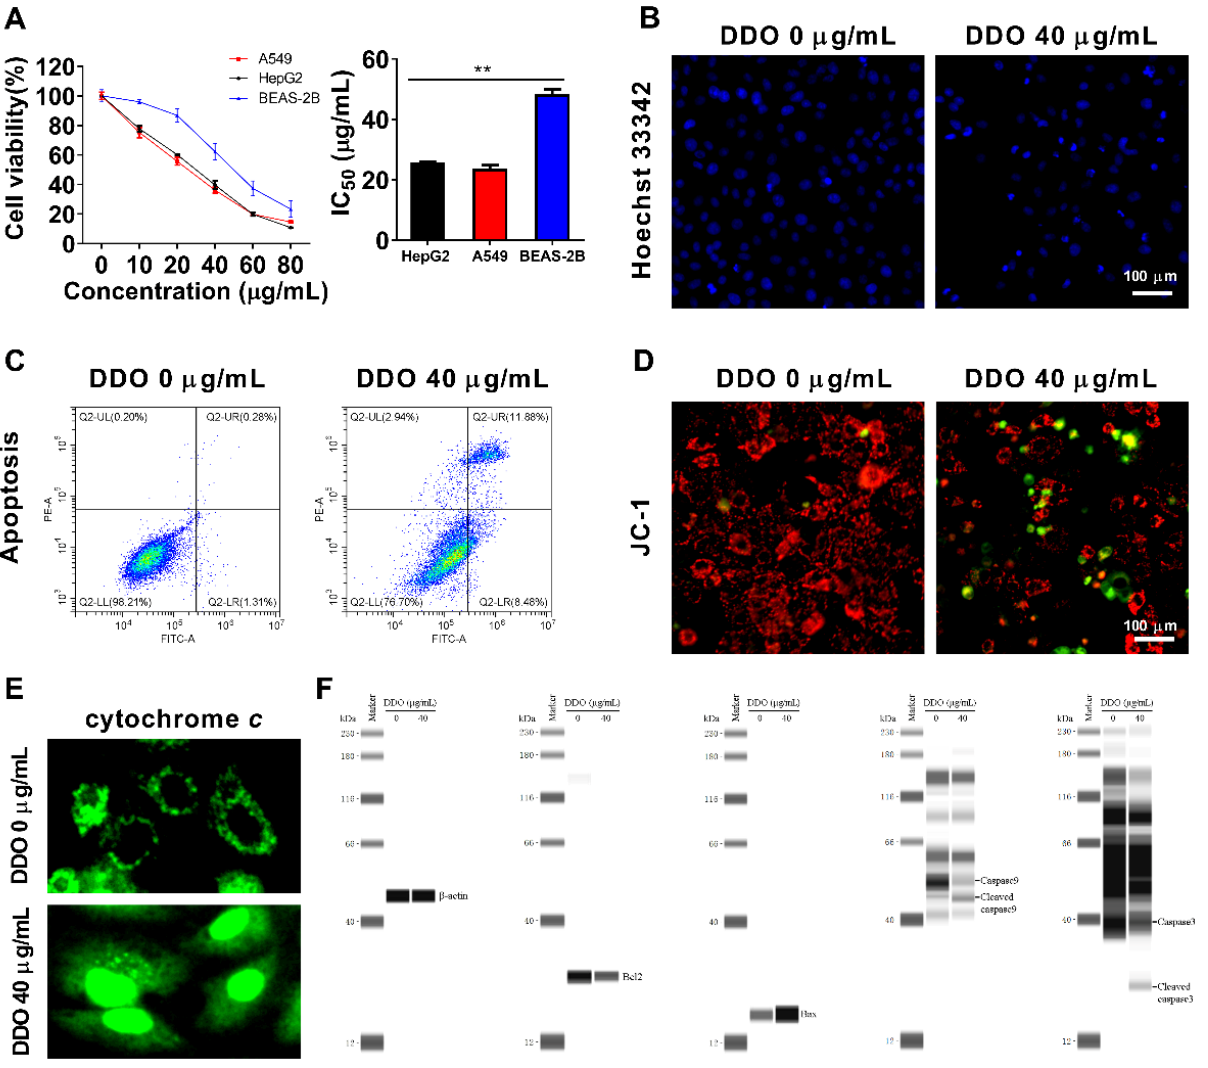
Figure 10. Cytotoxicity and apoptosis-inducing effect of compound DDO. HepG2, A549, and BEAS- 2B cells were treated with or without a series concentration of DDO for 24 h, then cell viability was determined by ( A ) CCK8 assay and IC 50 was calculated; the values represent mean ± standard devi- ation of three independent experiments. A549 cells were treated with DDO (40 µg/mL) for 24 h, apoptosis cells were stained with ( B ) Hoechst 33342 and ( C ) annexin V-FITC/PI kit, and detected with ImageXpress Micro Confocal High-Content Imaging System and flow cytometry, respectively. ( D ) After being treated with DDO (40 µg/mL) for 24 h, A549 cells were stained with JC-1 to observe the mitochondrial membrane potential. A549 cells were treated with DDO (40 µg/mL) for 9 h, ( E ) a part of cells was used for immunofluorescence analysis of the release of cytochrome c from mito-